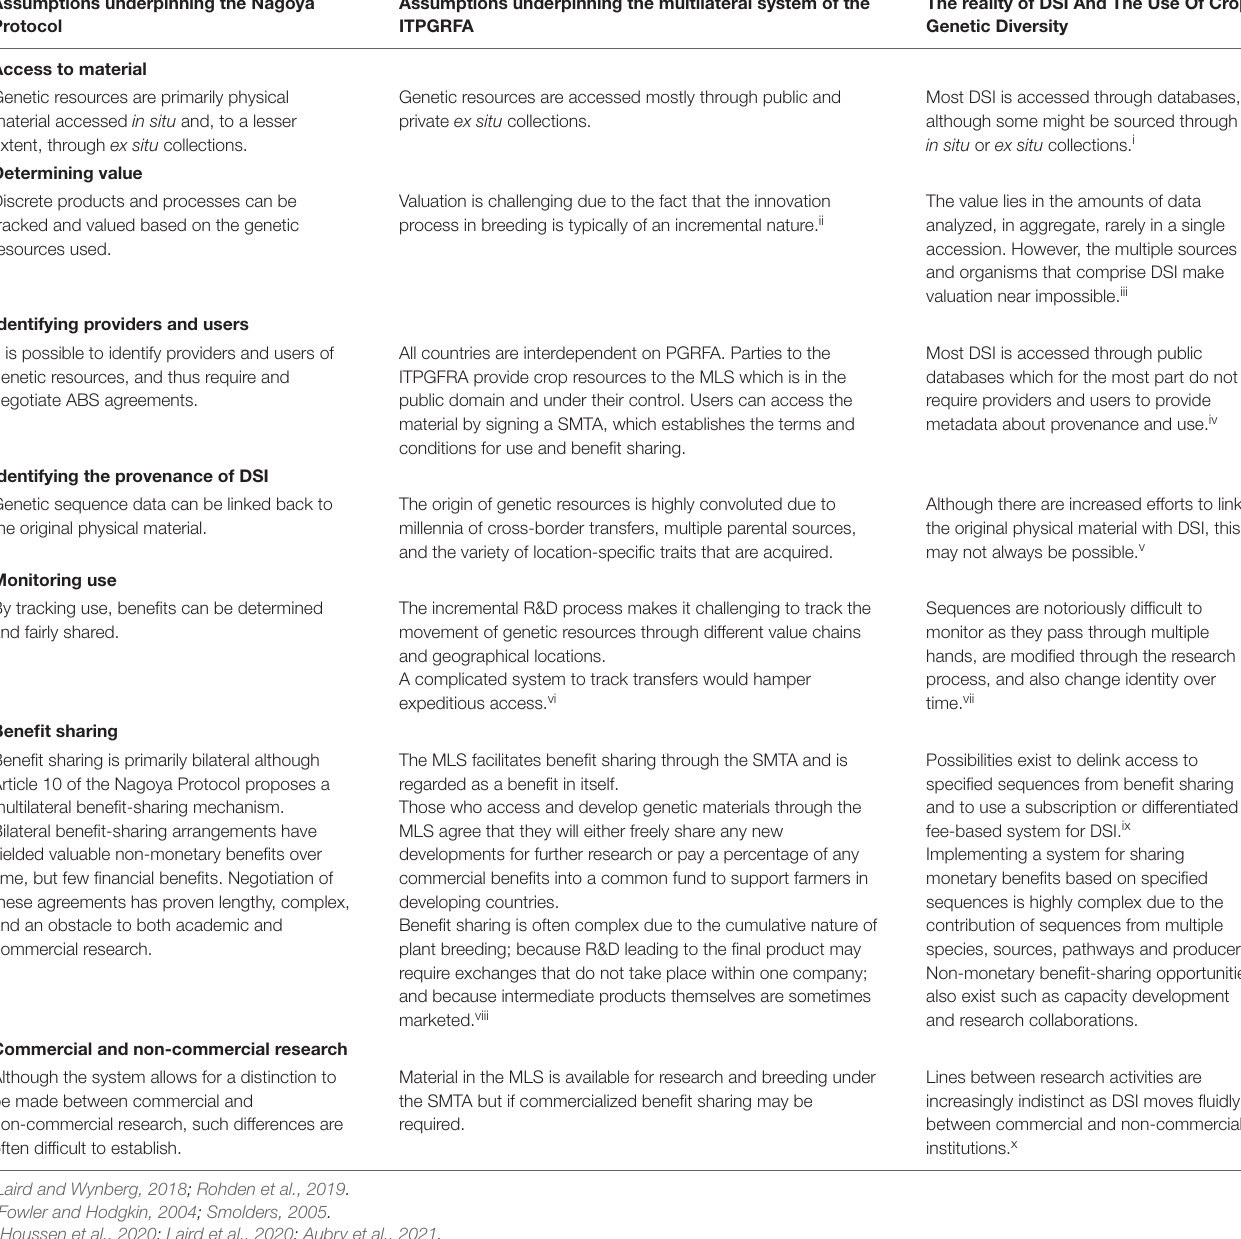
TABLE 1 | Facts and fiction. Assumptions underpinning the Nagoya Protocol and the multilateral system of the ITPGRFA – and the reality of DSI and the use of crop genetic diversity. Assumptions underpinning the Nagoya Protocol